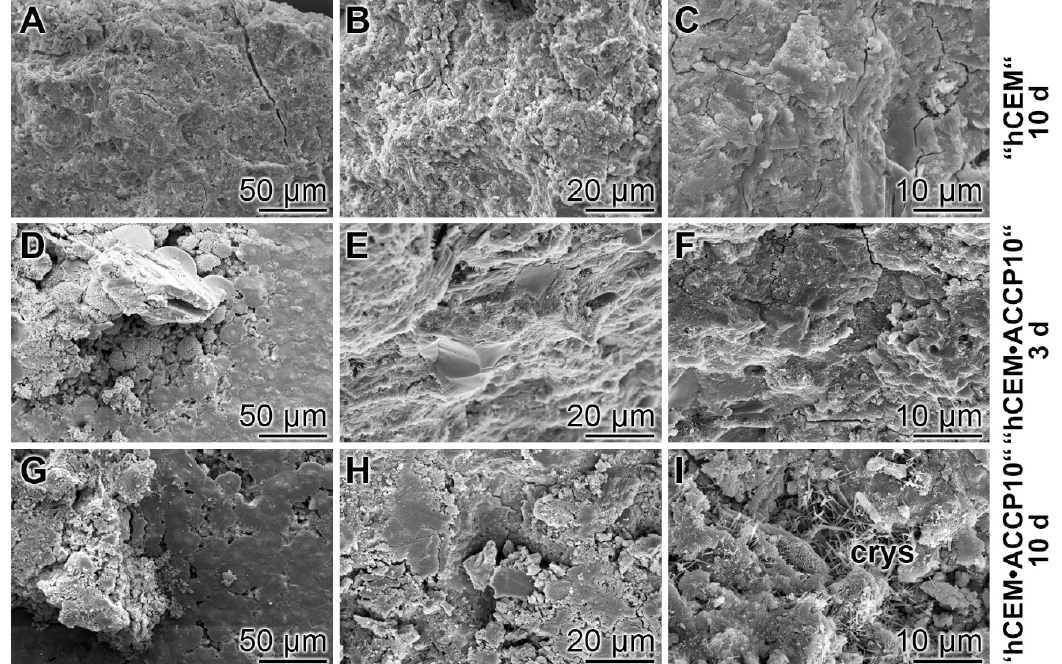
Figure 3. Surface structure of commercially obtained, unhydrated cement supplemented with water (“hCEM”) compared to cement, supplemented with “ACCP10”; ESEM. The ( A , B )